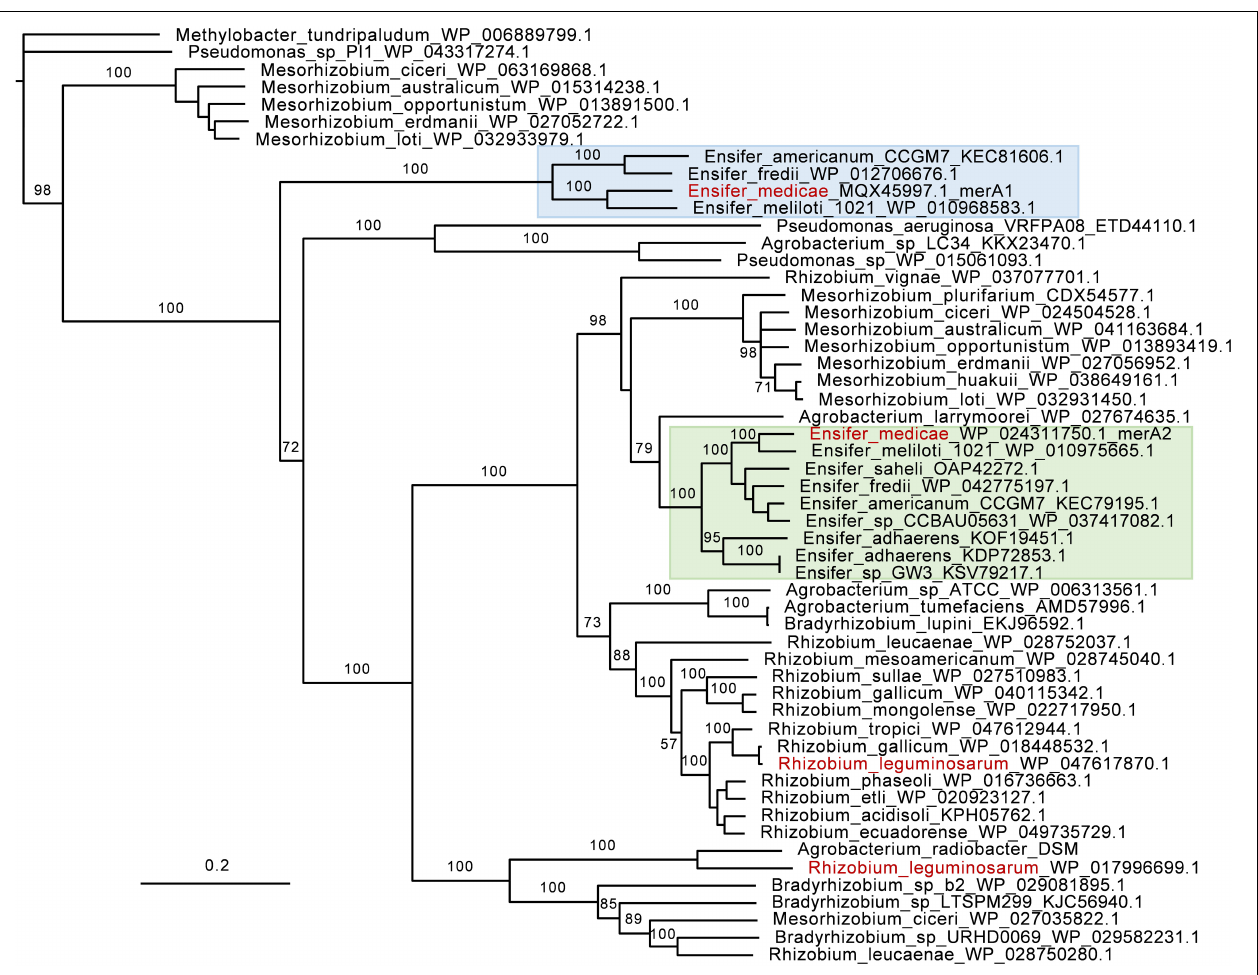
FIGURE 4 | Phylogeny of mercuric reductase (MerA) in rhizobia. GenBank accession numbers are indicated. The phylogeny is based on amino acid sequences. The tree was rooted using two non-rhizobia MerA from Methlybacter tundripaludum and Pseudomonas sp. as outgroup sequences. The Ensifer sp. clades for MerA1 and MerA2 homologes are highlighted in blue and green, respectively. Ensifer medicae and Rhizobium leguminosarum are shown in red